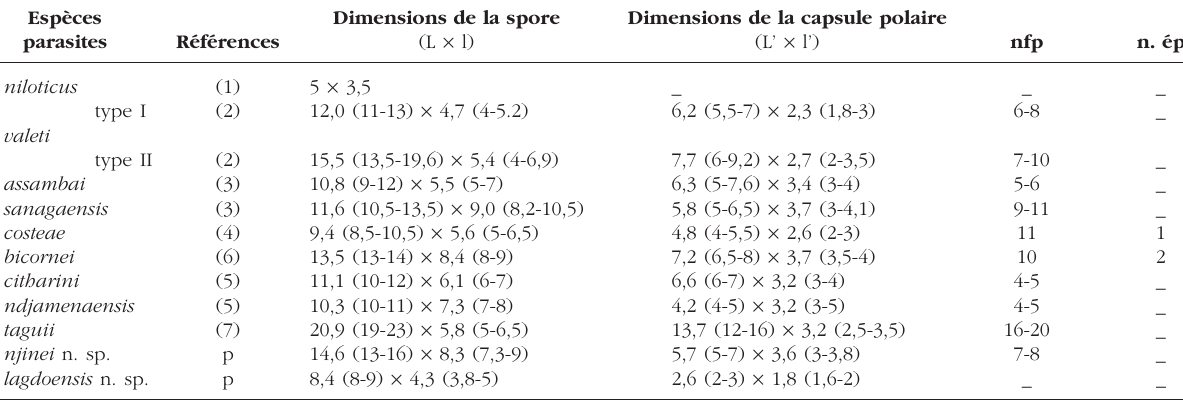
Espèces Dimensions de la spore Dimensions de la capsule polaire parasites